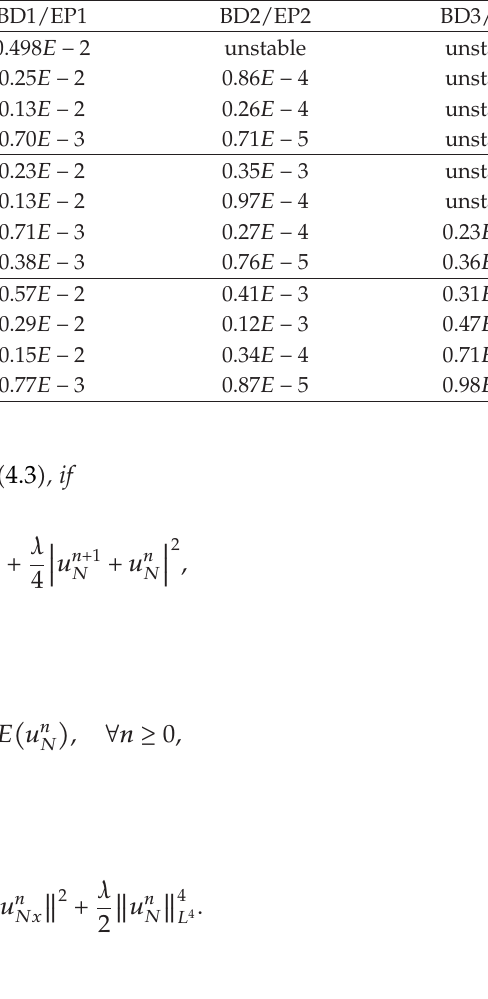
Table 2: Numerical errors obtained by using the BD1/EP1, BD2/EP2, and BD3/EP3 with λ (cid:6) ε (cid:6) 0 . 0025 and N (cid:6)